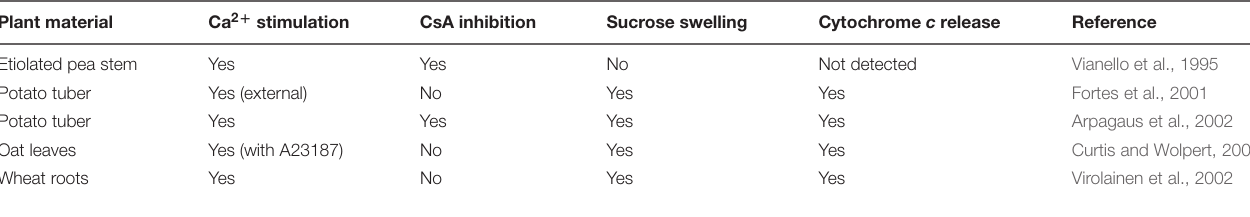
TABLE 1 | Characteristics of permeability transition (PT) in plant mitochondria. Plant